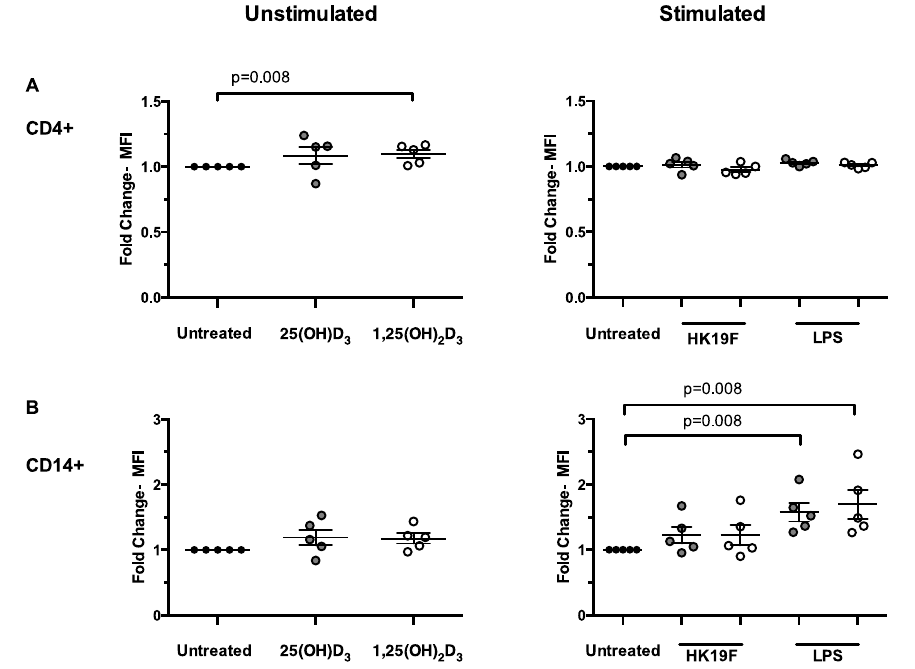
Figure 4. Effects of 1,25(OH) 2 D 3 pre ‐ treatment on the immunophenotype of PBMCs. Fold change in median fluorescence intensity (MFI) for ( A ) CD4 and ( B ) CD14 in PBMCs ( n = 5) pre ‐ treated with 1,25(OH) 2 D 3 or 25(OH)D 3 in comparison to unstimulated and HK19F/LPS stimulation. Data represents the mean fold change ± SEM. Significance was calculated using a Mann ‐ Whitney test (black bar = untreated, grey bar = 25(OH)D 3 and white bar = 1,25(OH) 2 D 3 ).